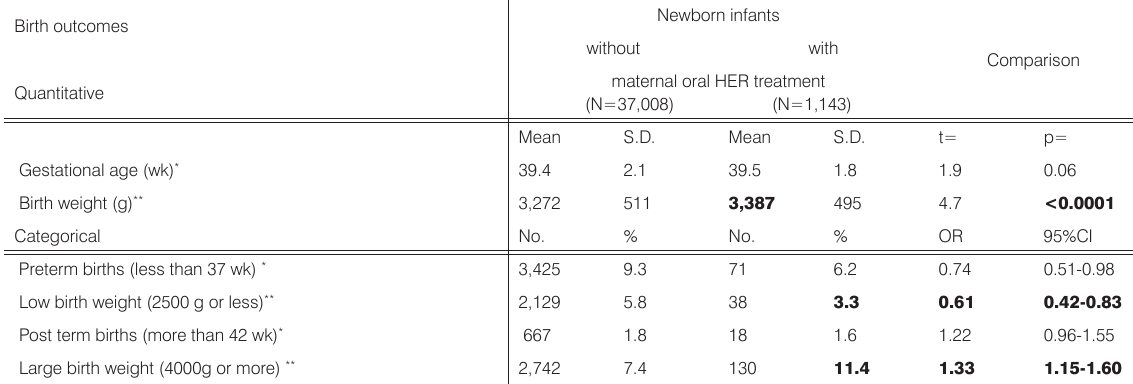
Table 2. Birth outcomes of newborn infants born to mother with oral HER treatment and without HER treatment as reference Birth